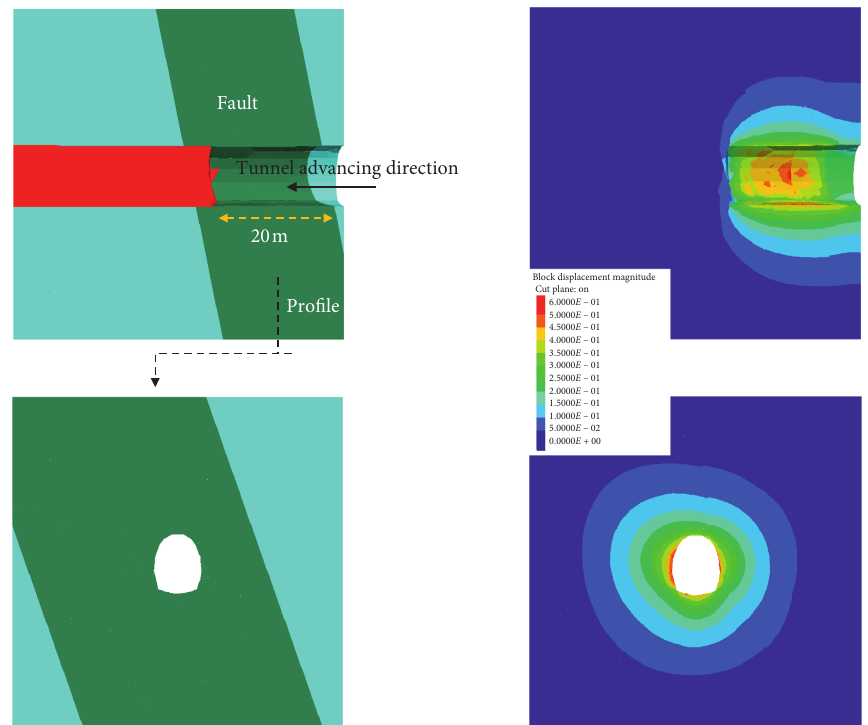
Figure 5: The tunnel enters the fault area of